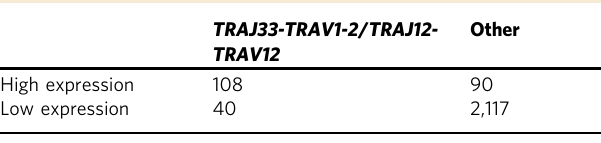
The high expression indicates the cells whose SLC4A10 expression is greater than 1 and the low expression are other cells. Fisher ’ s exact test (two-sided) gives a p -value smaller than 10 − 16